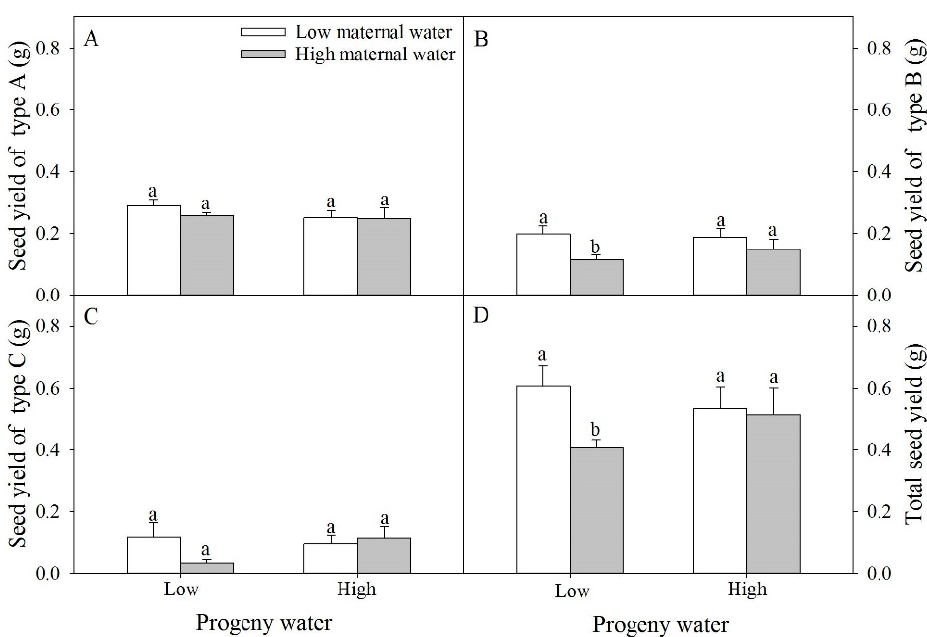
Figure 5. Effects of maternal and progeny water treatments on ( A ) seed yield of type A, ( B ) seed yield of type B, ( C ) seed yield of type C, and ( D ) total seed yield per plant. Different lowercase letters represent significantly different means between plants with different maternal water treatments under the same progeny water treatment according to t -test ( p < 0.05).